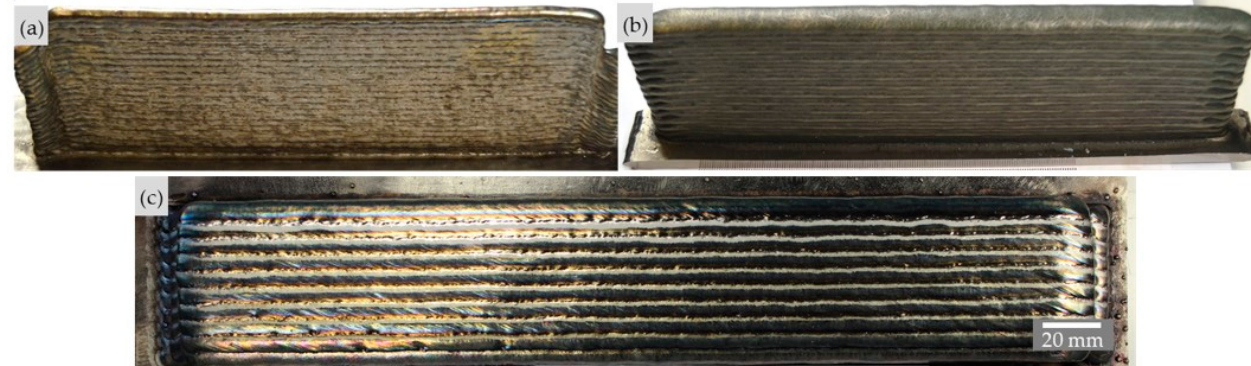
Figure 6. Side views of brushed walls. ( a ) WFS: 8.0 m/min, TS: 0.8 m/min; ( b ) WFS: 11.0 m/min, TS: 0.6 m/min; ( c ) top view of the unbrushed block with WFS: 14.0 m/min, TS: 0.4 m/min (Z-ArHeHC).